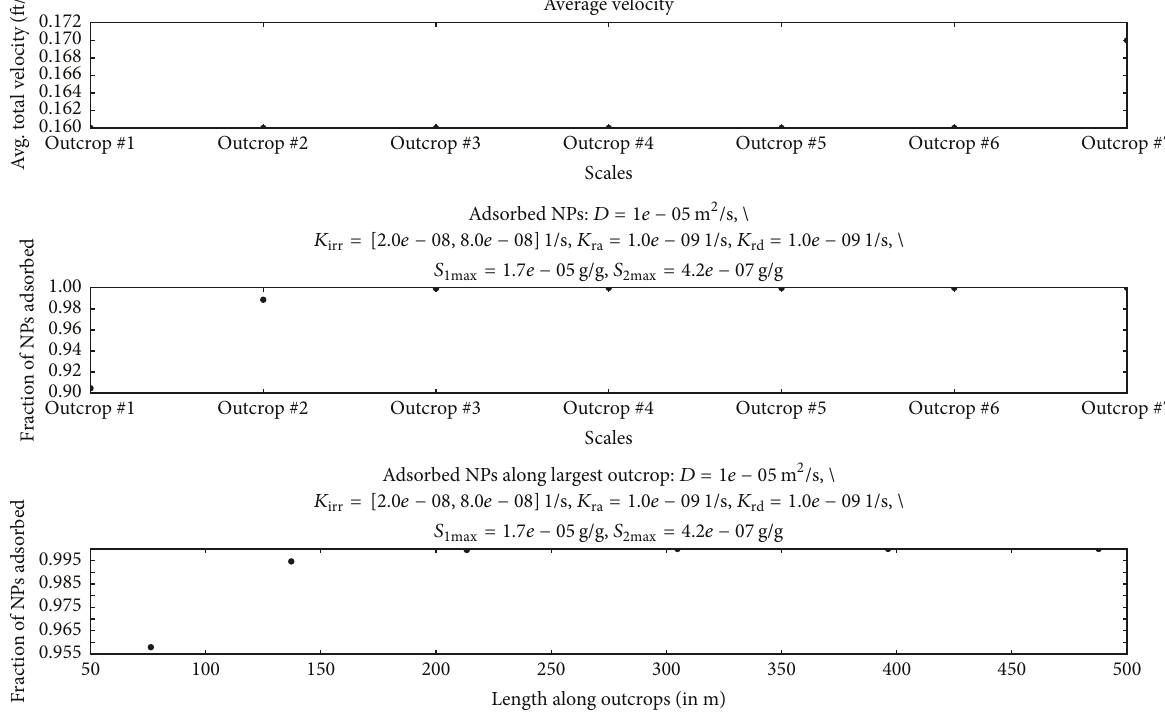
Figure 12: Fraction of NPs retained in seven outcrops and at distances equal to smaller outcrops in the longest outcrop. The results reported are for 4 pore volumes of injected